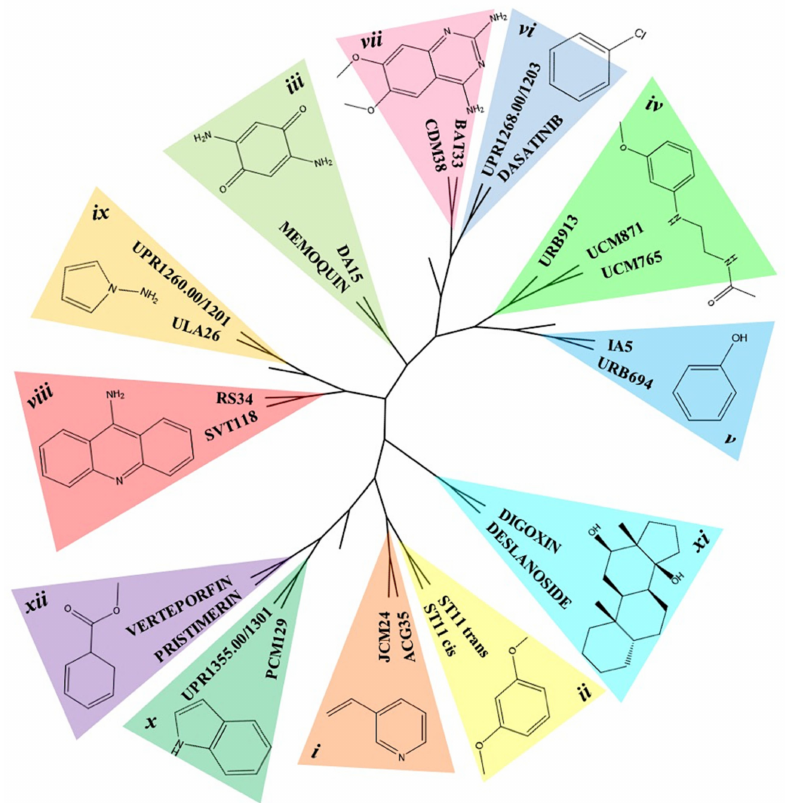
Figure 4. TreeMap. This figure summarizes the clusters identified from the hierarchical clustering analysis. The chemical core-structures and the compounds populating each cluster are